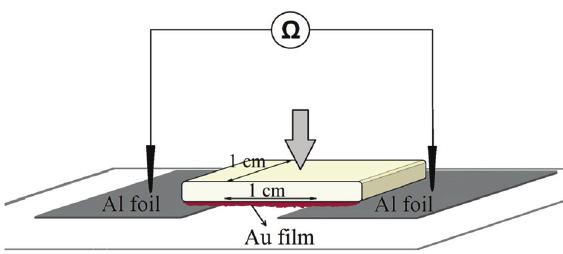
Figure 1. Resistance measurement of 1.0 cm 2 of Au thin film on glass substrate.